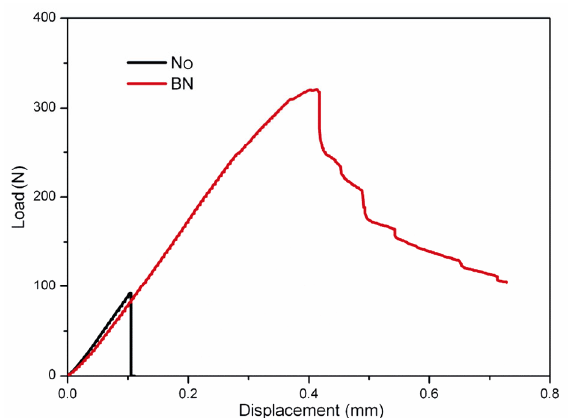
Fig. 4 Load–displacement curves of the KD-S SiC f /SiC composites with and without BN interface layer.